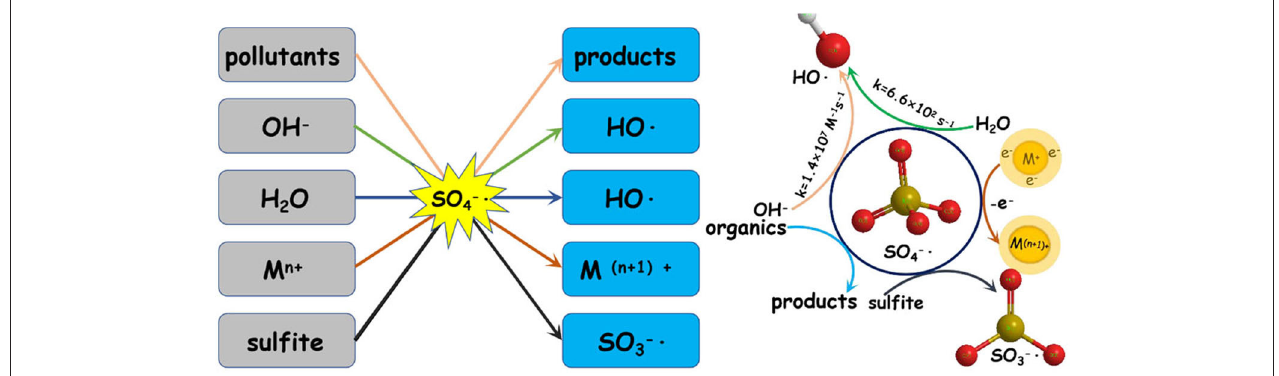
FIGURE 2 | The role of sulfate radical in the sulfate-radical-based advanced oxidation process (SR-AOP) systems.